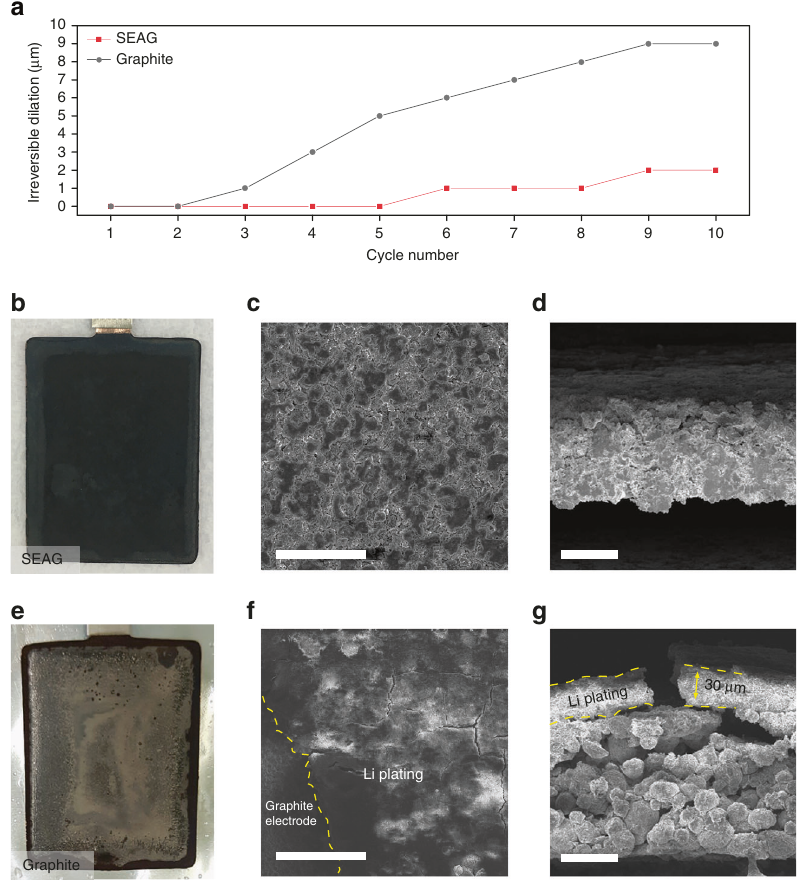
Fig. 6 Dimensional and morphological changes of the electrodes after fast-charging cycles. a Irreversible increase in thickness of the electrode at the delithiated state under 7.7 mA cm − 2 for 10 cycles. Photographs of b SEAG electrode and e graphite electrode after 50 cycles at 7.7 mA cm − 2 . Top view and cross-sectional SEM images of c , d SEAG electrode and f , g graphite electrode. Yellow dash line indicates the deposited Li, which reacted with the electrolyte. Scale bars, c 100 μ m, d , g 50 μ m, f 400 μ